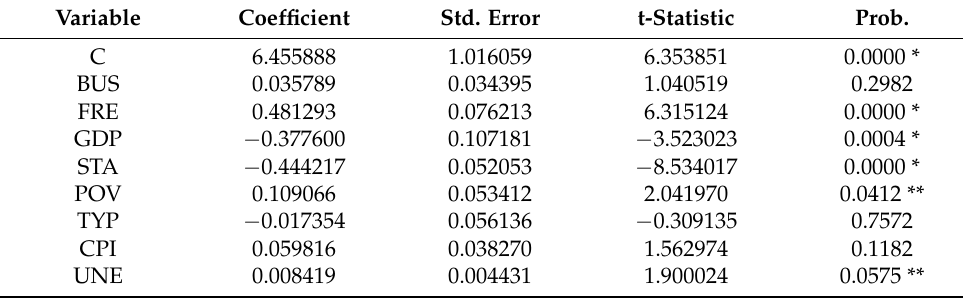
Table 7. Fixed effect model (FEM)—CS fixed (dummy